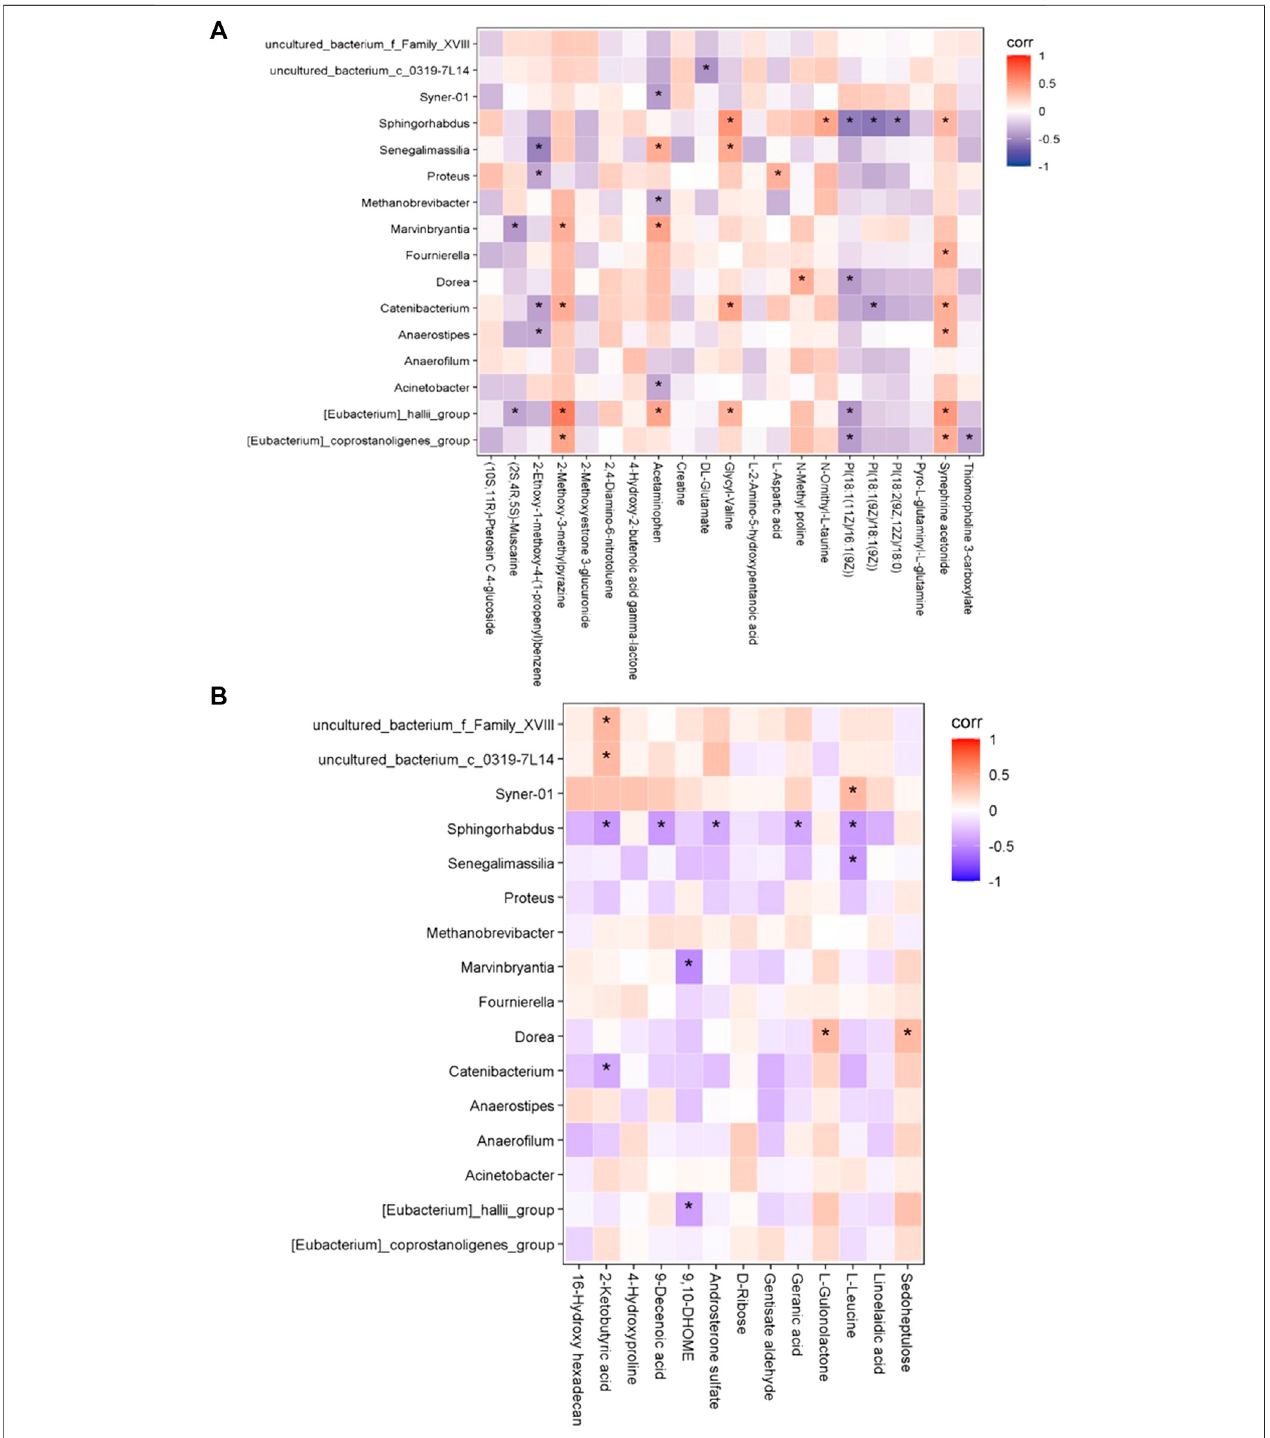
FIGURE6 | Thecorrelation between gut microbiome and serum metabolomic. (A) In positiveion model (B) In negative ion model. Red: up-regulation, blue: down- regulation, gray: not signi fi cant, * p < 0.05.